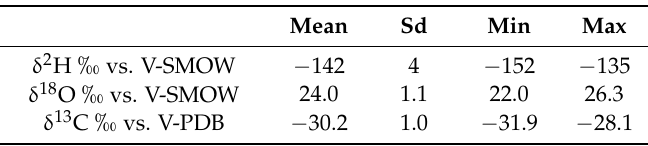
Table 2. δ 2 H, δ 18 O and δ 13 C of olive oils.